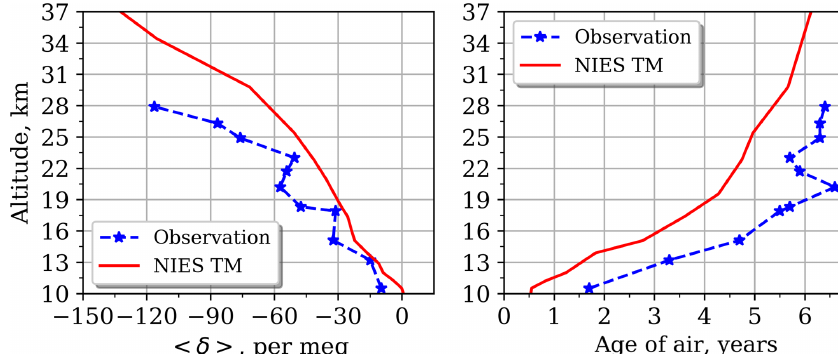
Figure 6. Same as Fig. 5 but over the Kiruna site for 18 March 1997.